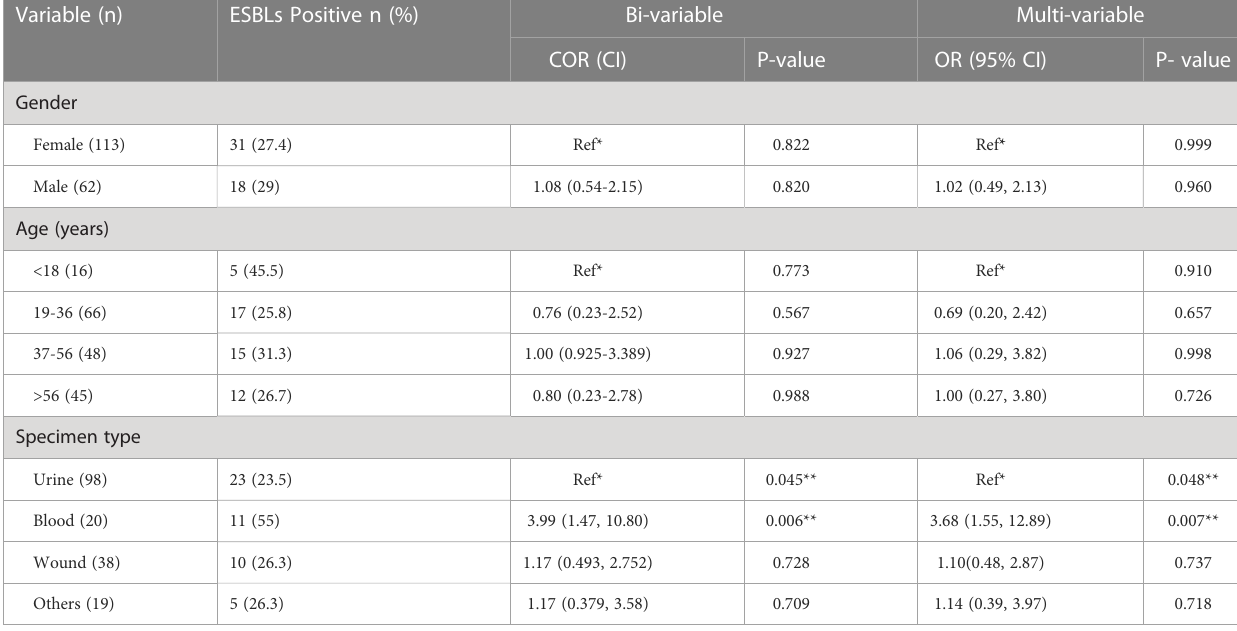
TABLE 6 Association of gender, age and types of specimens with magnitude of extended spectrum b -lactamases producing gram negative